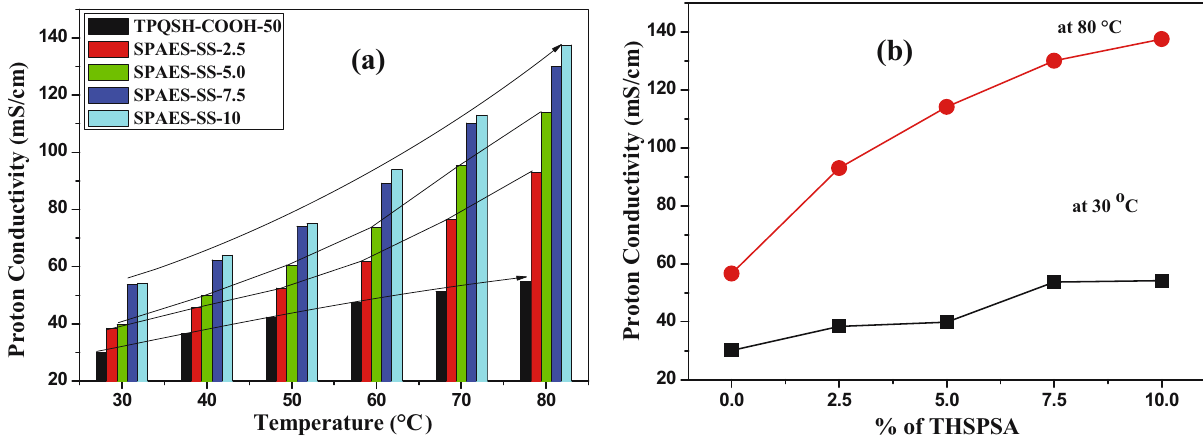
Figure 10: ( a ) Proton conductivity of bare copolymer and composite membranes. ( b ) Variation in proton conductivity with % of THSPSA at di ff erent temperatures under fully hydrated conditions of SPAES - SS - X hybrid